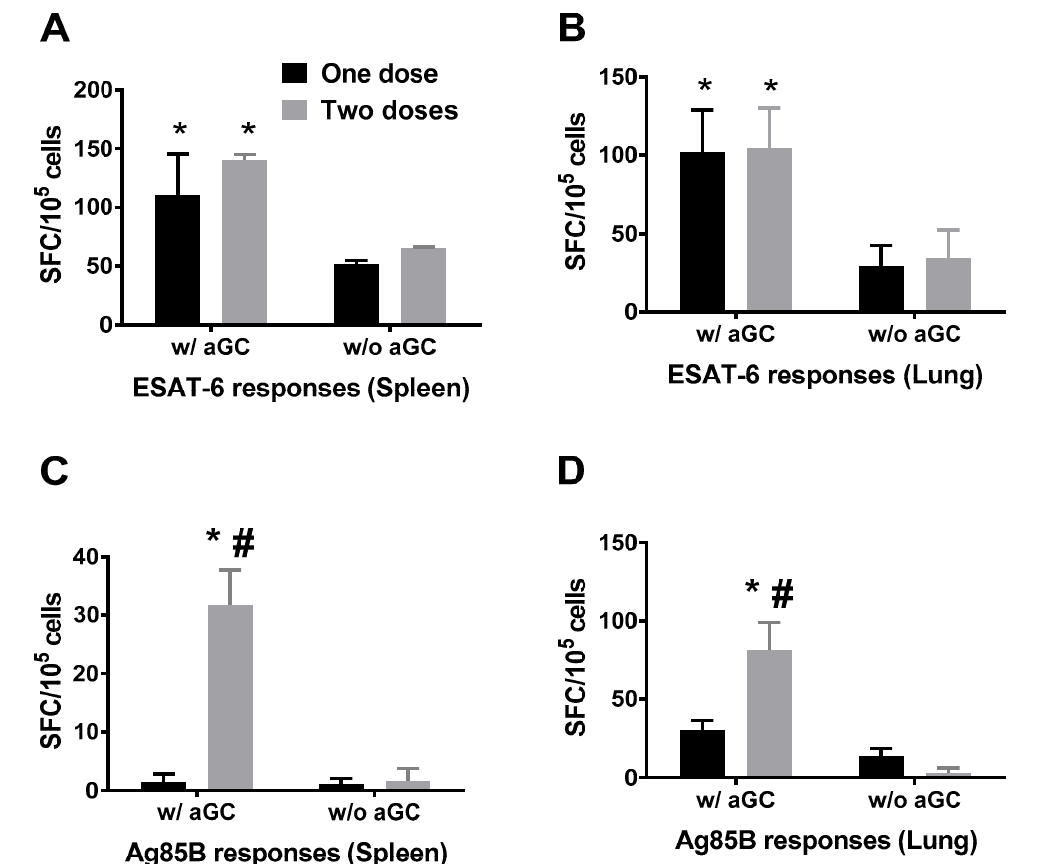
Figure 1. Sublingual immunization with Mycobacterium tuberculosis (Mtb) proteins Ag85B and ESAT-6 in the presence of alpha-galactosylceramide ( α -GalCer) adjuvant induces systemic and mucosal T cell responses. Separate groups of mice ( n = 4–6) were immunized by sublingual route with one or two doses of mixture of Mtb proteins Ag85B and ESAT-6 in the presence or absence of α -GalCer adjuvant (w/aGC and w/o aGC, respectively) at 7 day intervals and sacrificed 7 days after each immunization to determine immune responses. Single cell suspensions from spleen and lung tissues were